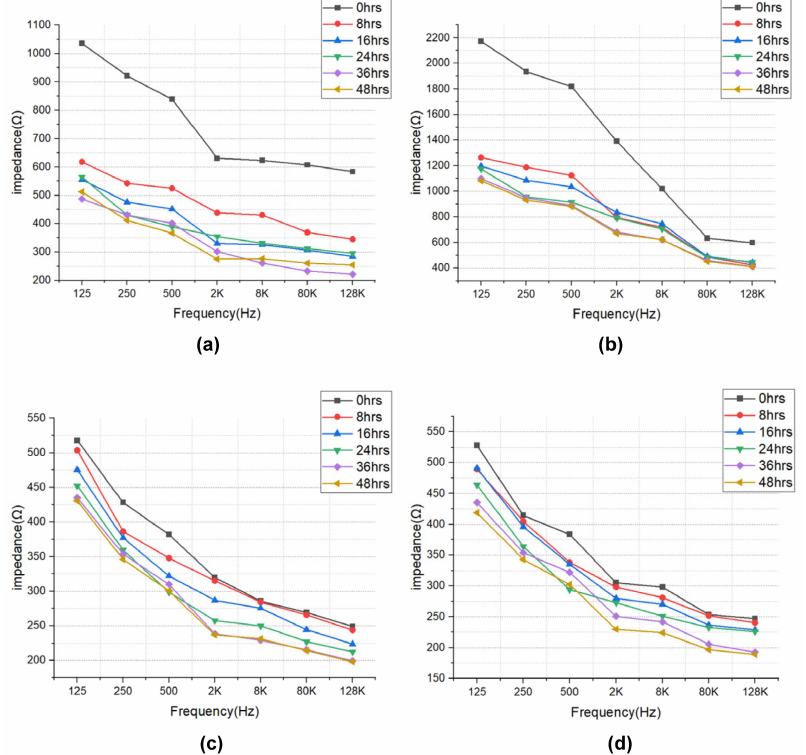
Figure 5. EIS of ( a ) beef loin (quality grade 1+), ( b ) beef loin (quality grade 1), ( c ) beef round (quality grade 1+), and ( d ) beef round (quality grade 1) measured over the storage